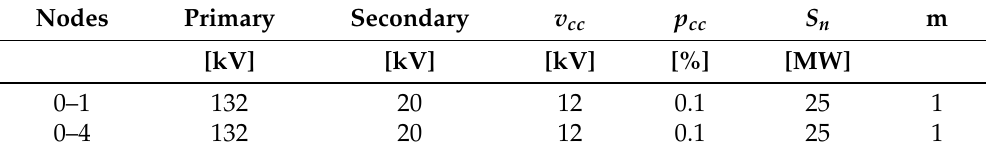
Table 11. Data transformers.